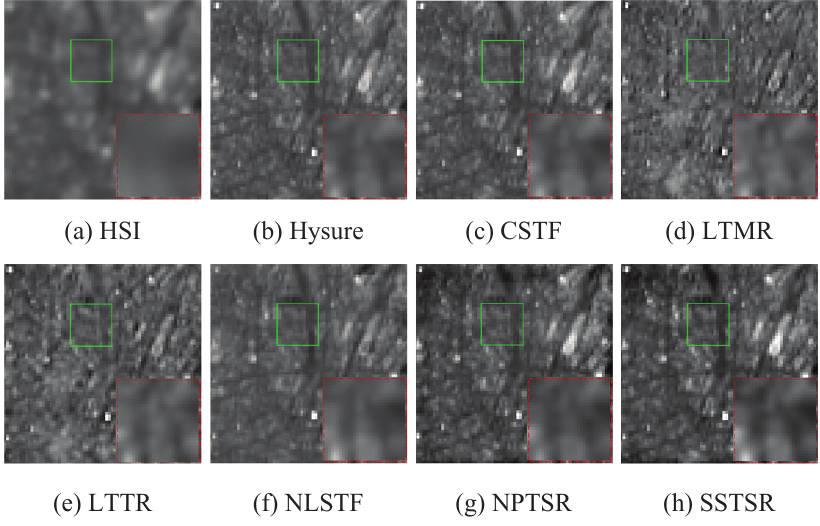
Figure 10. Super-resolution results of all comparison methods at band 90 on real data